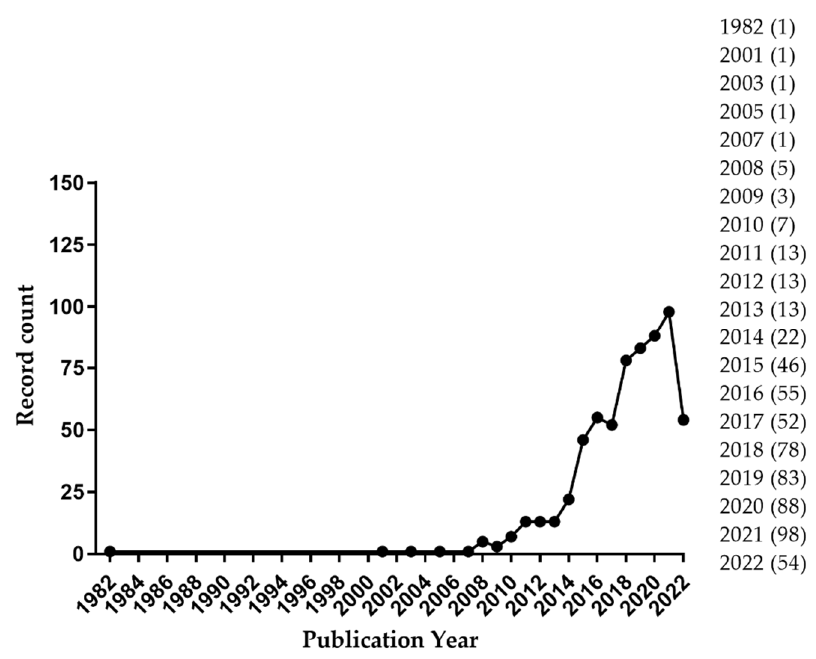
Figure 1. Time analysis of patent documents. First year of priority.